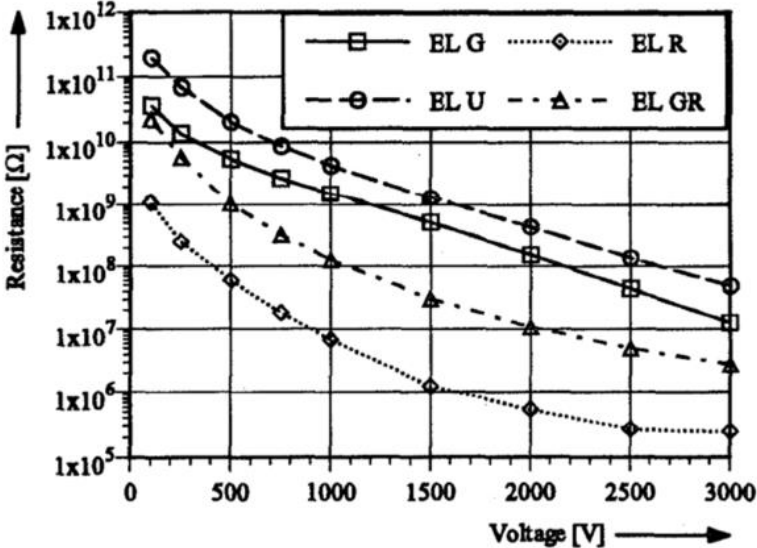
Figure 21. Influence of doping in SiC/epoxy composites. © 2021 IEEE. Reprinted, with permission, from [65].